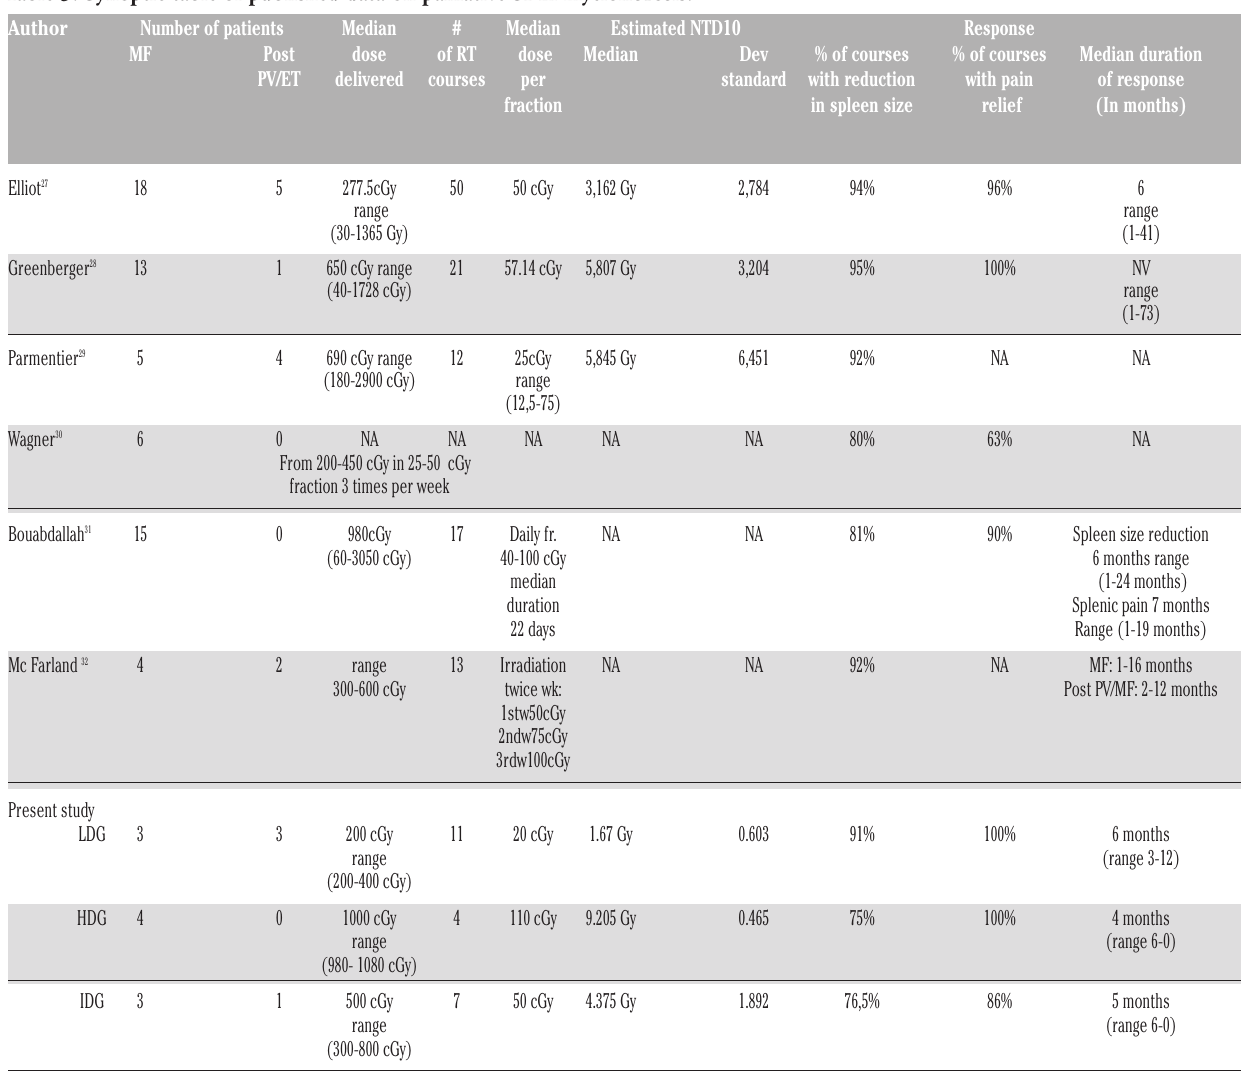
Table 3. Synoptic table of published data on palliative SI in myelofibrosis.